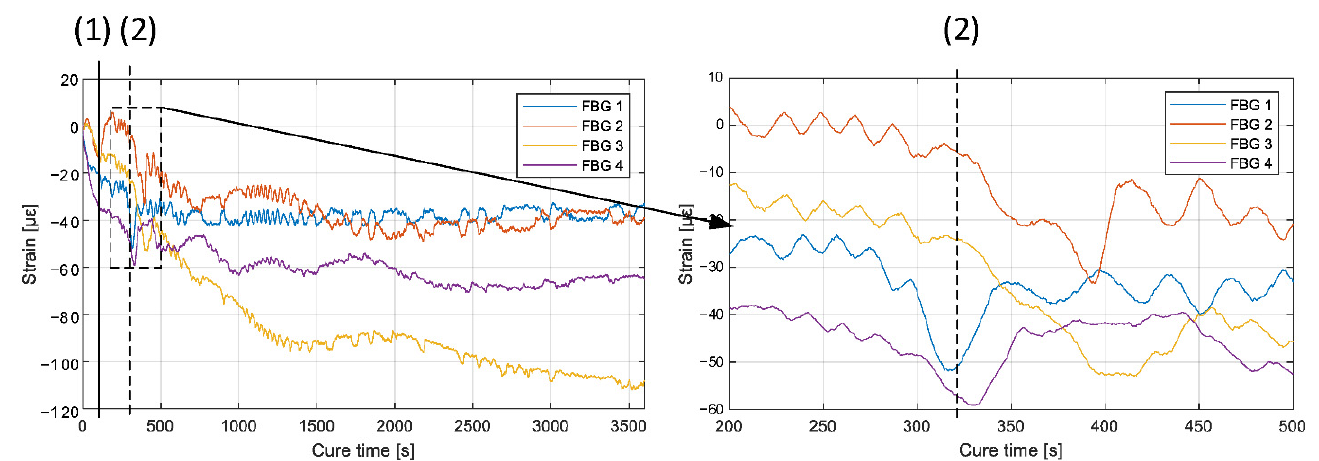
Figure 6. Strain evolution during the RTM process, measured with single-mode FBG sensors; (1)— (1)—inlet hose clamping, (2)—range of gelation time estimated from DC sensor data. inlet hose clamping, (2)—range of gelation time estimated from DC sensor data.